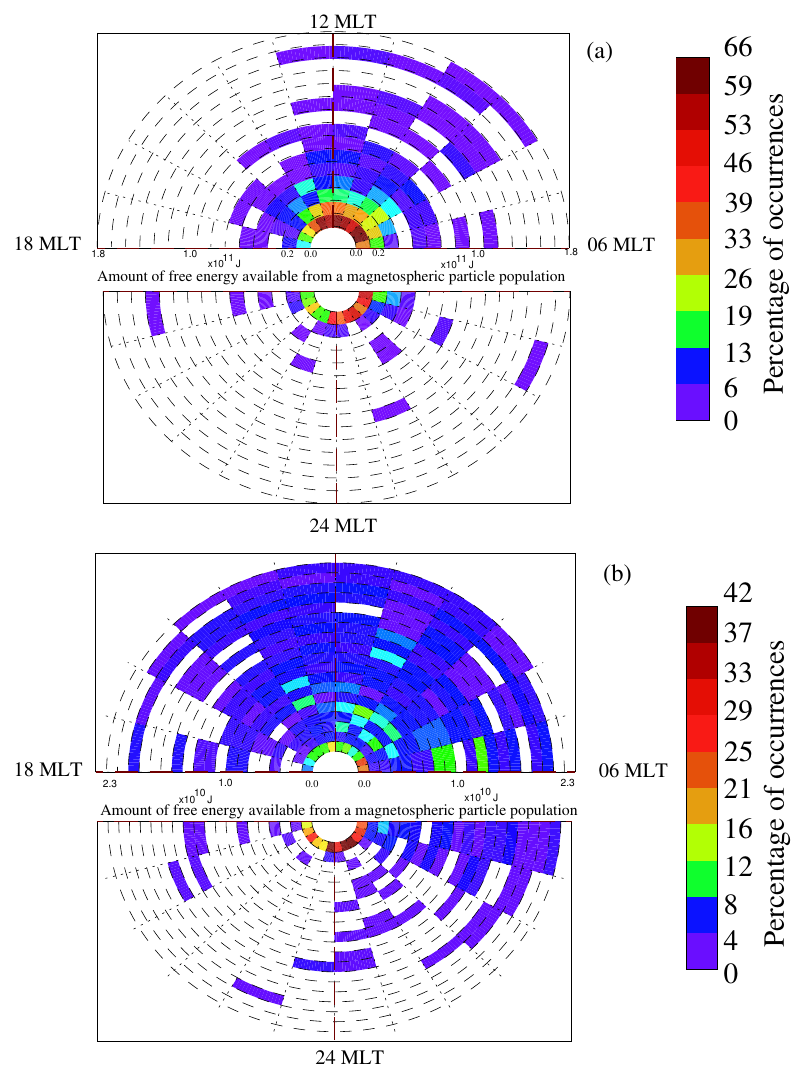
Fig. 5. Results from a statistical study of magnetospheric particle populations, using the TIMAS and CAMMICE (MICS) instruments. Two Figure 5. years of data were binned according to MLT location and also according to the amount of free energy each IDF contained in the form of Figure 5. a positive gradient region. The radial distance from the centre of the circle indicates increasing amounts of free energy available up to a maximum of ( a ) 1.8 × 10 11 J in bin increments of 1.2 × 10 10 J and ( b ) up to a maximum of 0.23 × 10 11 J in bin increments of 1.2 × 10 9 J. The data bins are colour coded as a percentage occurrence in that MLT